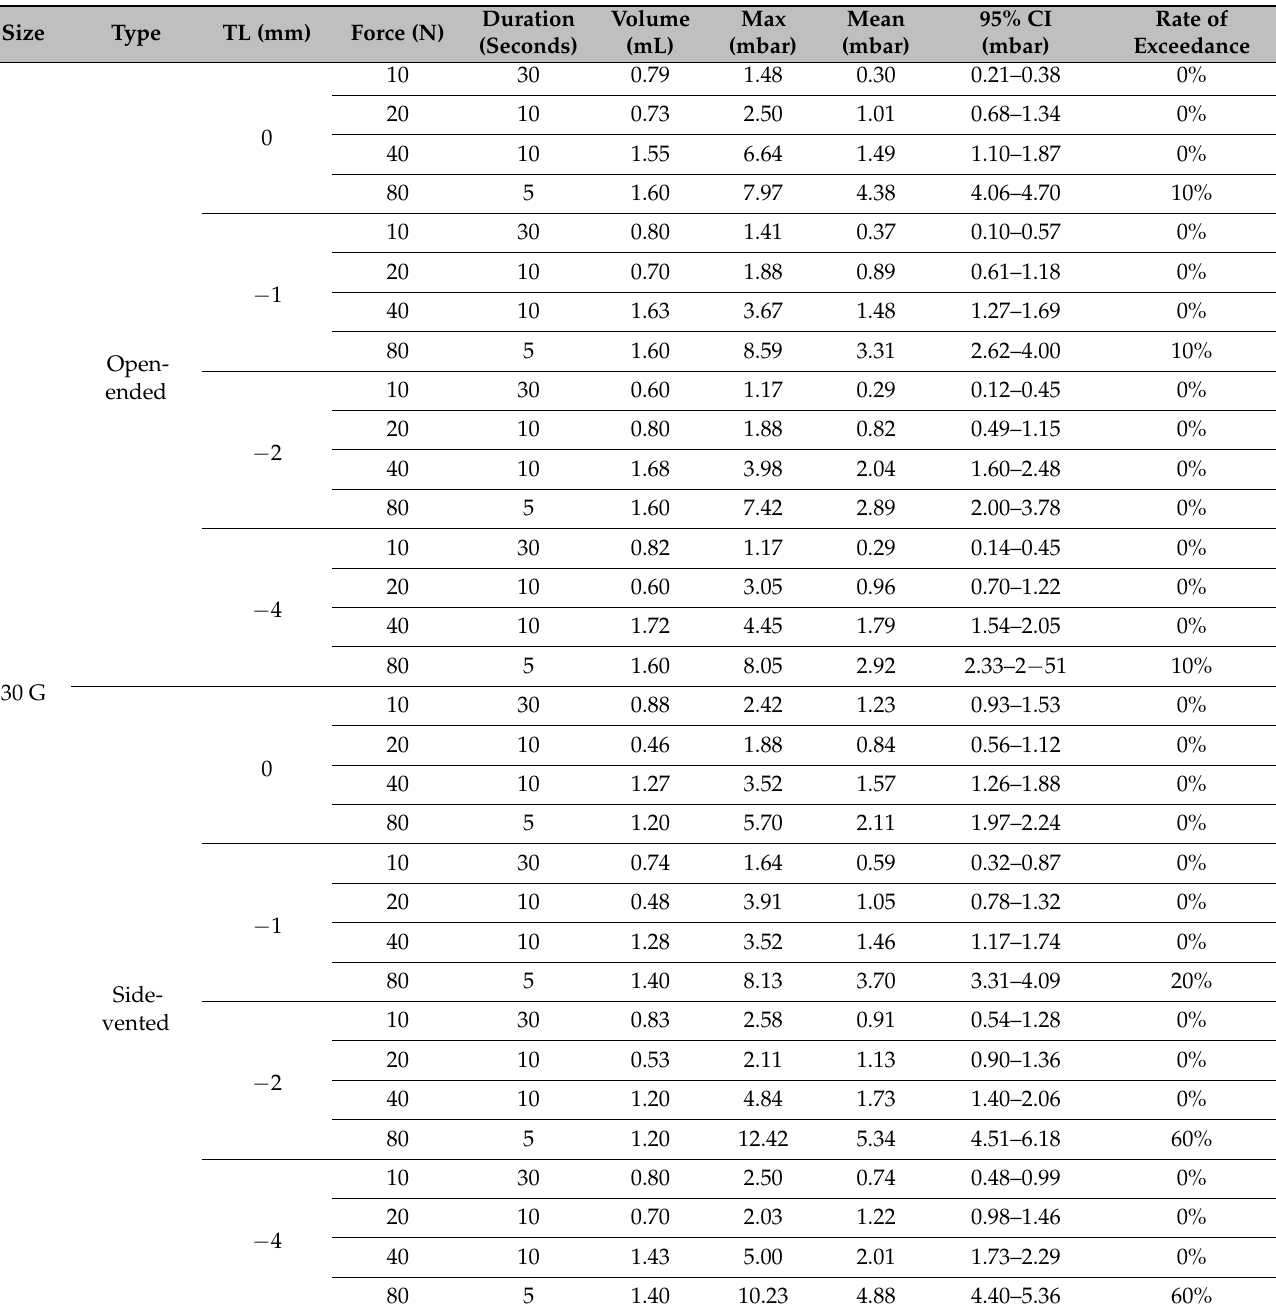
Table 1. Results of all measurements with the size of the needle, needle tip design, TL, plunger force, duration, volume, max- imum, mean, 95% confidence interval, and percentage of exceedance of the critical threshold per group ( n = 10 per group). Size